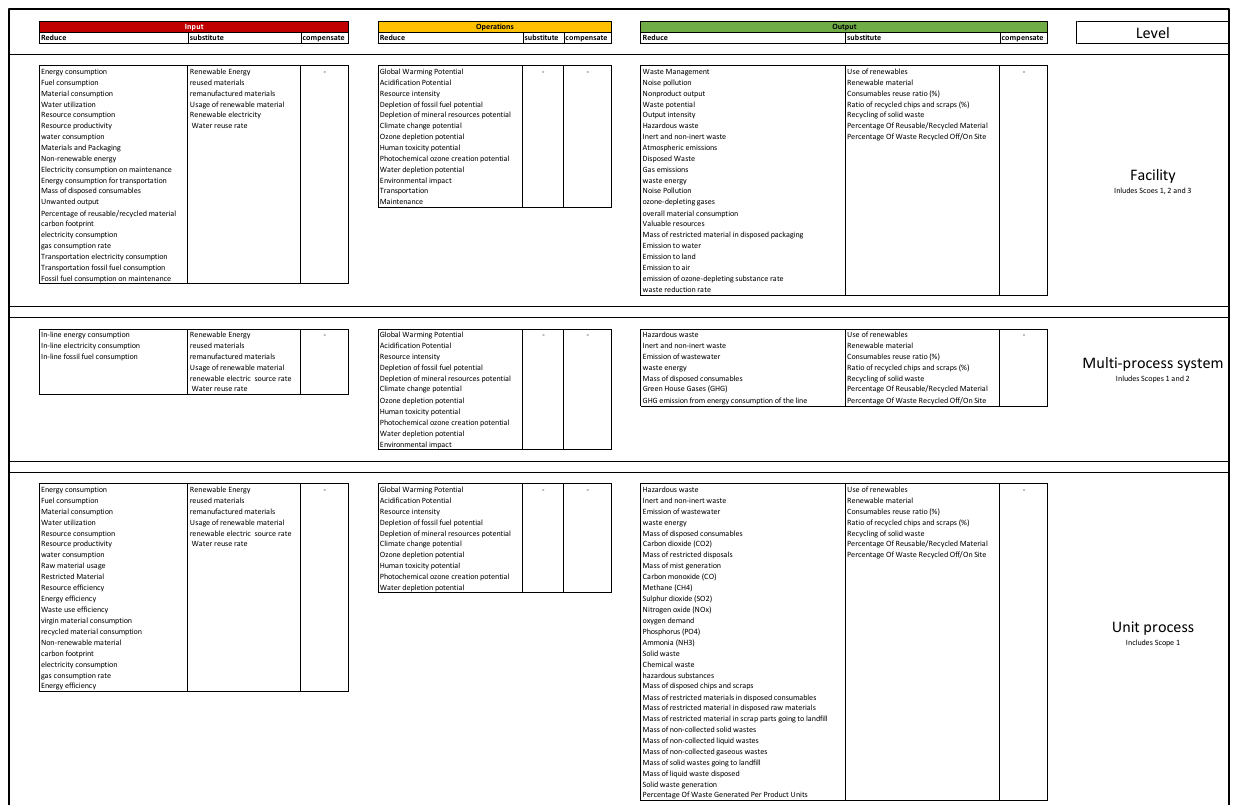
Figure A1. The collected metrics and the categorisation exercise performed as a part of the study to create initial knowledge database. Total number of metrics collected: 147, after removing duplicates: 111.